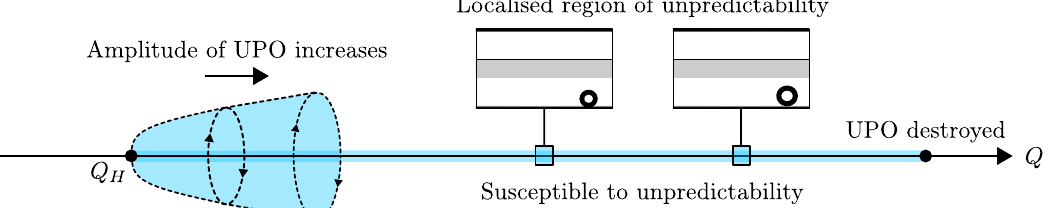
Figure 10. Schematic of the region of parameter space that is susceptible to unpredictable dynamics; this region persists from the birth of the UPO at Q H until the UPO is destroyed. As Q increases beyond Q H , larger